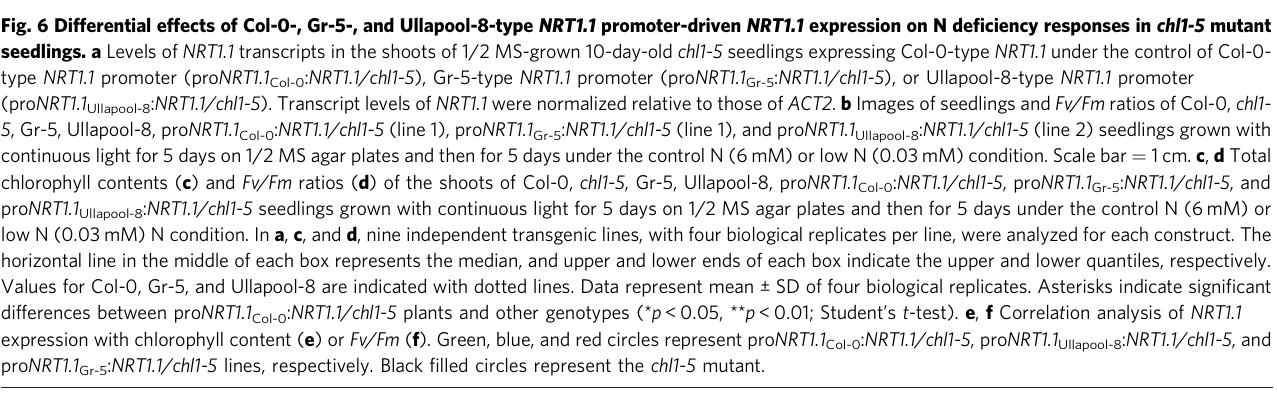
Fig. 6 Differential effects of Col-0-, Gr-5-, and Ullapool-8-type NRT1.1 promoter-driven NRT1.1 expression on N de fi ciency responses in chl1-5 mutant seedlings. a Levels of NRT1.1 transcripts in the shoots of 1/2 MS-grown 10-day-old chl1-5 seedlings expressing Col-0-type NRT1.1 under the control of Col-0- type NRT1.1 promoter (pro NRT1.1 Col-0 : NRT1.1/chl1-5 ), Gr-5-type NRT1.1 promoter (pro NRT1.1 Gr-5 : NRT1.1/chl1-5 ), or Ullapool-8-type NRT1.1 promoter (pro NRT1.1 Ullapool-8 : NRT1.1/chl1-5 ). Transcript levels of NRT1.1 were normalized relative to those of ACT2 . b Images of seedlings and Fv/Fm ratios of Col-0, chl1- 5 , Gr-5, Ullapool-8, pro NRT1.1 NRT1.1/chl1-5 (line 1), pro NRT1.1 NRT1.1/chl1-5 (line 1), and pro NRT1.1 NRT1.1/chl1-5 (line 2) seedlings grown with Col-0 : Gr-5 : Ullapool-8 :